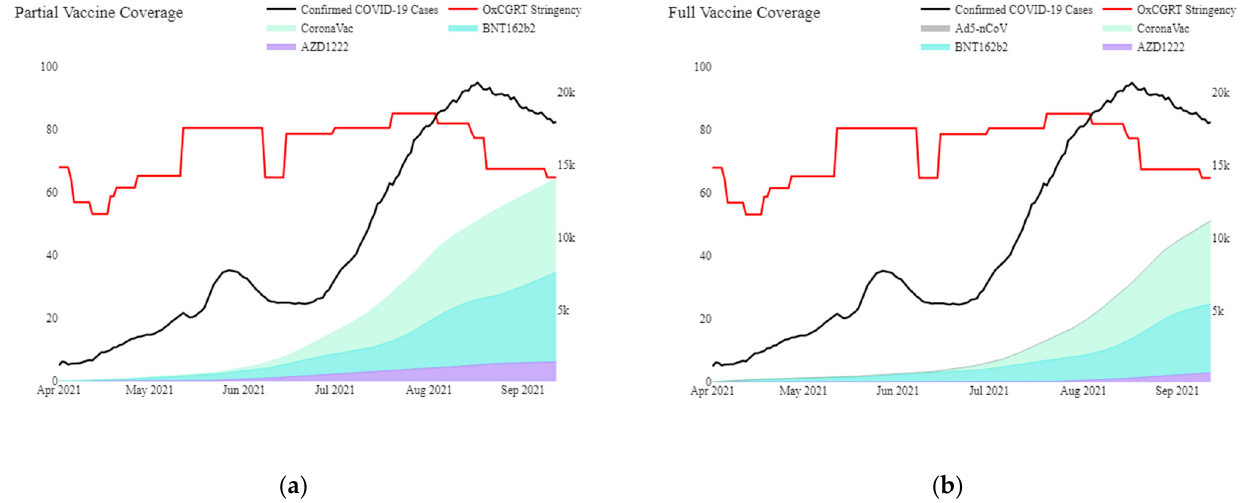
Figure A1. COVID ‐ 19 vaccine coverage, daily new confirmed COVID ‐ 19 cases, and the OxCGRT Stringency Index in Malaysia from 1 April 2021 to 15 September 2021. ( a ) Partially vaccinated; ( b ) fully vaccinated.